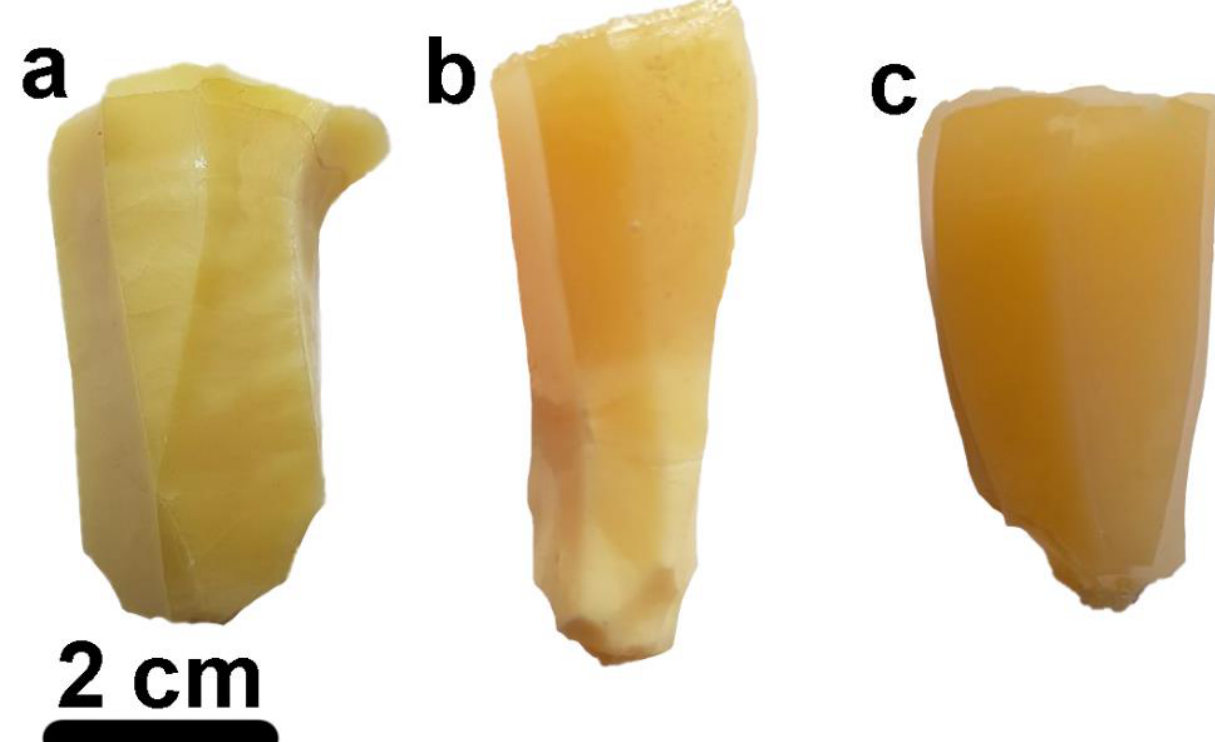
Figure 1. Photographic images of (ZrO 2 ) 1 − x (Sm 2 O 3 ) x crystals: ( a ) (ZrO 2 )0.98(Sm 2 O 3 ) 0.02 , ( b ) (ZrO 2 ) 0.097 (Sm 2 O 3 ) 0.03 and ( c ) (ZrO 2 ) 0.96 (Sm 2 O 3 ) 0.04.